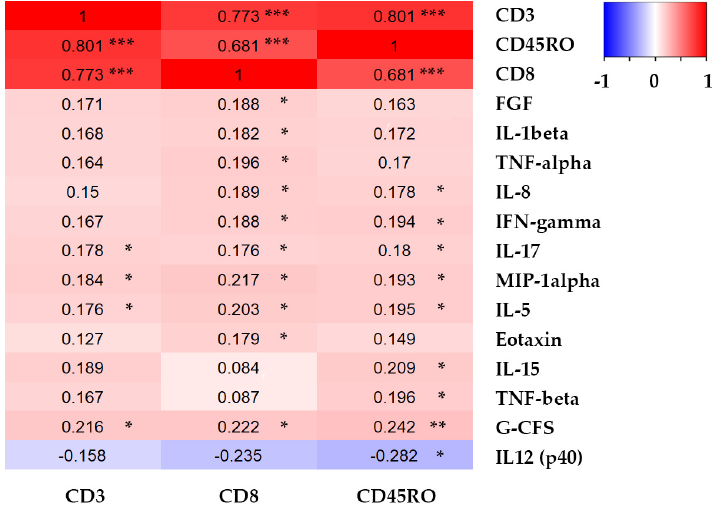
Figure 5. Heatmap showing correlation coe ffi cients for significant correlations (highlighted by asterisks) found between CD3, CD8, and CD45RO TILs infiltration (%) and plasma concentrations of selected cytokines (pg /